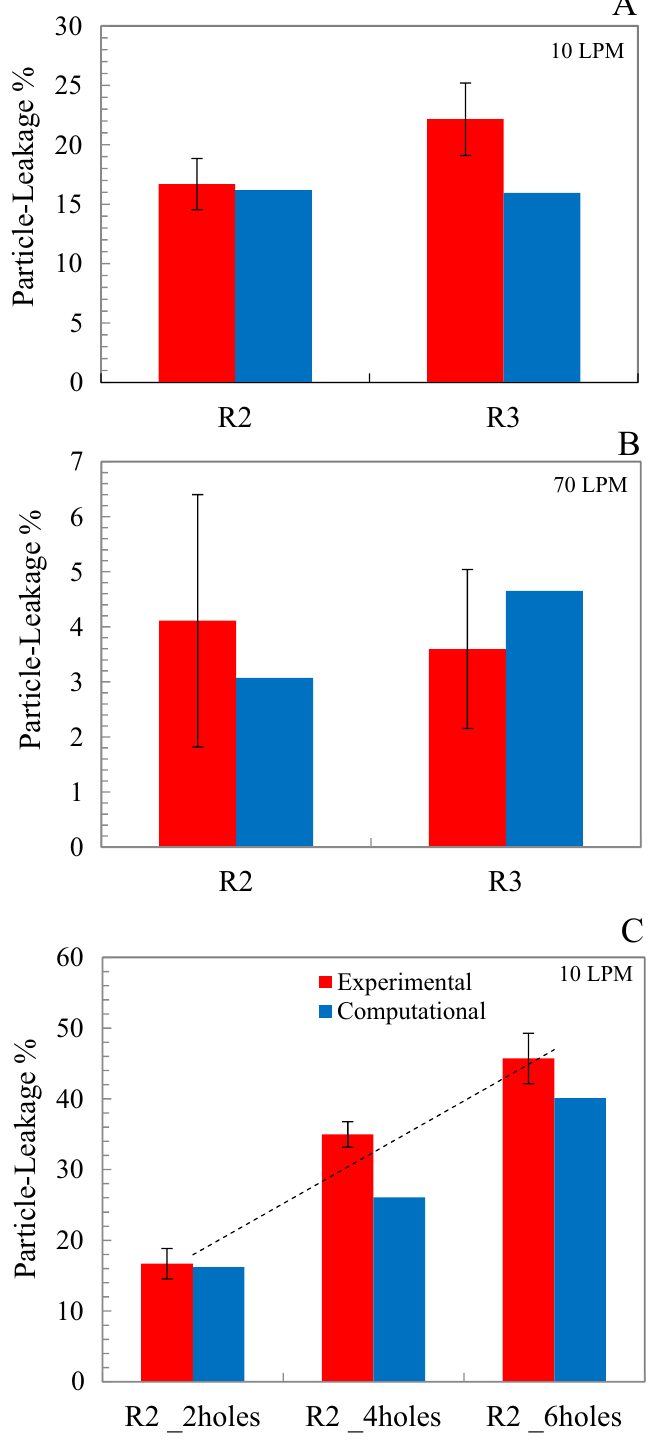
Figure 7. Experimental and computational particle-transmission % for flat plate ( A ) Resting breathing rate of 10 LPM ( B ) Exercising breathing rate of 70 LPM ( C ) For R2 with increase in number of holes at breathing rate of 10 LPM (R 2 = 0.98); n = 3 for